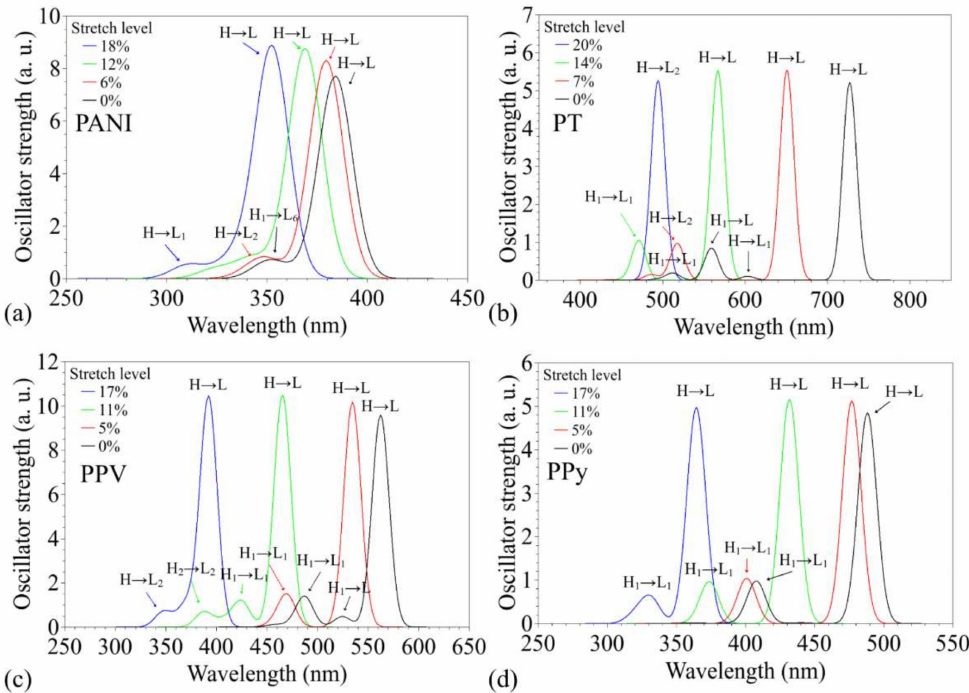
Figure 8. Summary of the changes on the optical absorption spectra of the polymers during the stretching process: ( a ) PANI, ( b ) PT, ( c ) PPV, and ( d ) PPy.